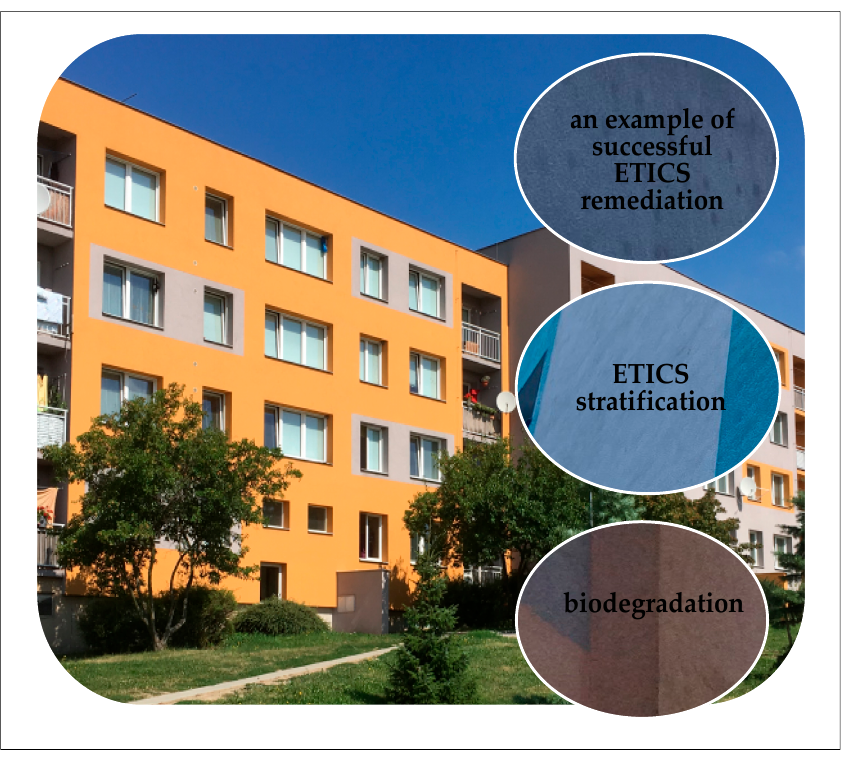
Figure 7. An example of a prefab residential housing building after a well-executed ETICS renovation and examples of defects and failures of the external wall due to poor technology in the application of ETICS (photo source: Author’s archive [26]).